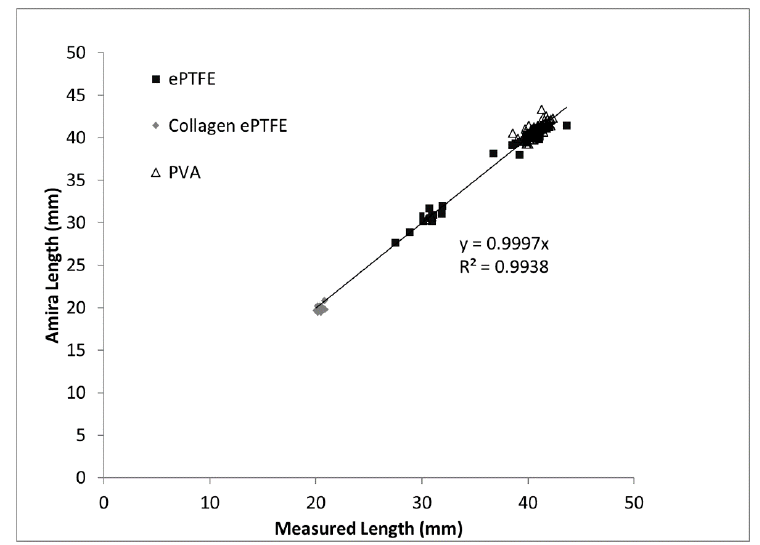
Figure 6. Comparison of caliper measured graft length to Amira-generated graft length for each material type.